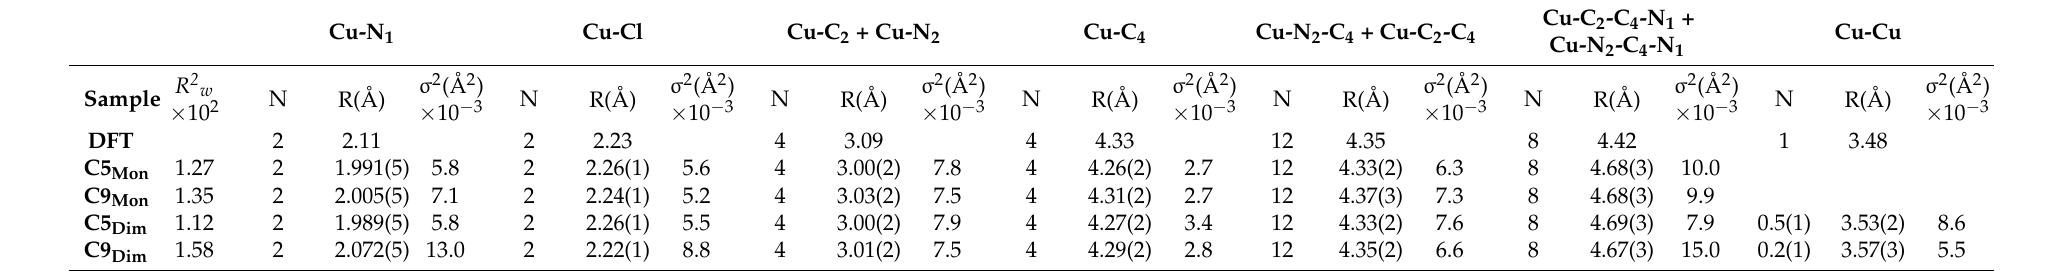
Table 2. Best fit results from the EXAFS analysis of complexes 5 and 9 . The first line reports the multiplicity numbers and average half scattering path lengths as obtained from Avogadro DFT model. In fitting the path, multiplicity numbers were constrained to a molecular model. The lower R 2 w points out the statistically better